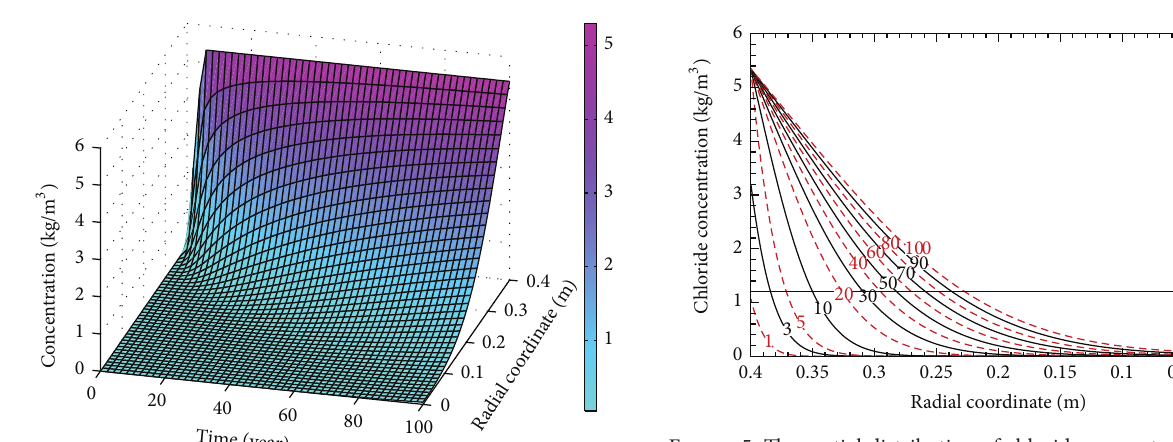
Figure 5: The spatial distribution of chloride concentration for 13 exposure scales, extracted from Figure 4. Also plotted in the figure is the CTL (1.2kg/m 3 ) required for corrosion